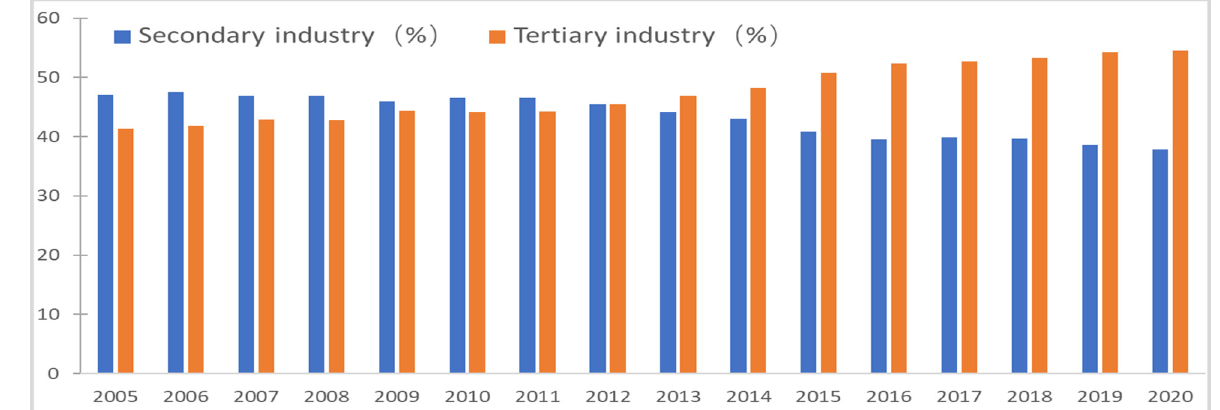
Figure 2. Comparative analysis on the proportion of secondary and tertiary industry.